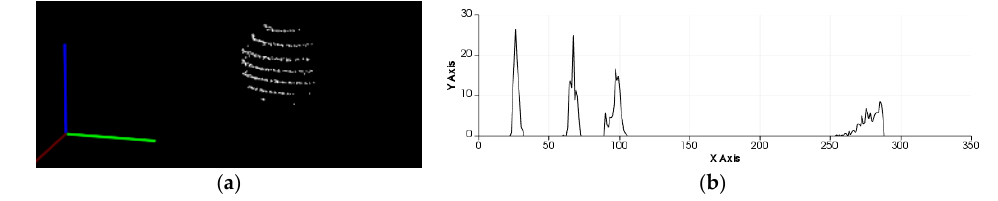
Figure 9. Results of VFH descriptor extraction: ( a ) Basketball’s point clouds visualization; ( b ) VFH of the basketball.